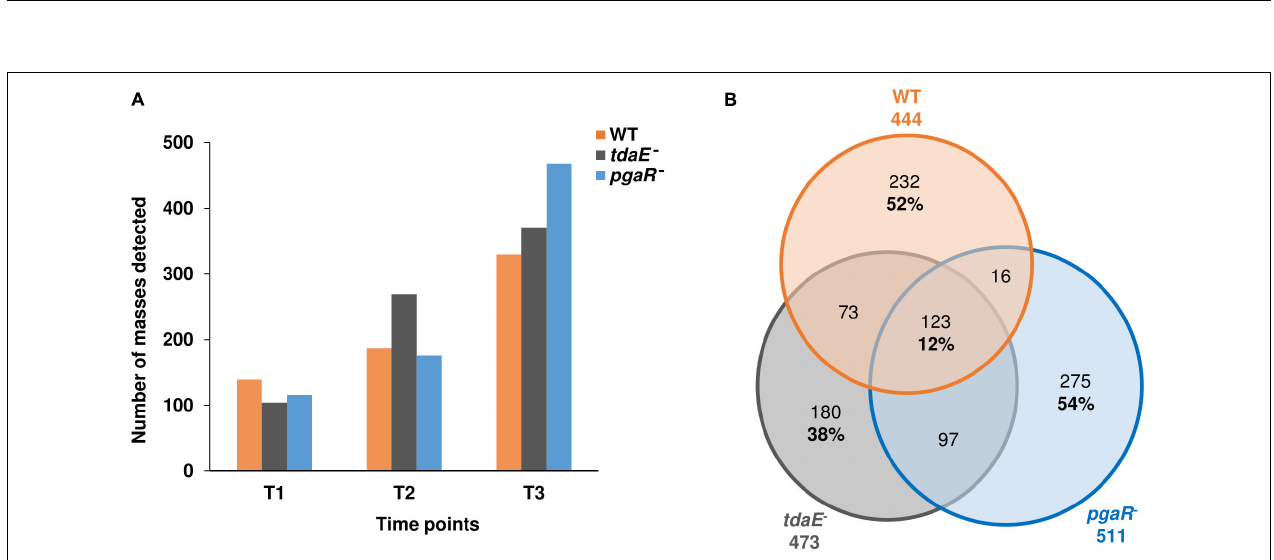
FIGURE 3 | Overall richness of exometabolomes. (A) Number of masses detected in the exometabolome of P. inhibens DSM 17395 wild type (WT), tdaE − mutant and pgaR − mutant at lag (T 1 ), mid-exponential (T 2 ) and early stationary (T 3 ) growth phases. (B) Venn diagram showing the number of unique and shared masses detected in the exometabolome of P. inhibens DSM 17395 WT (orange), tdaE − mutant (gray) and pgaR − mutant (blue) over all time points. Only masses detected in all biological replicates of each strain were considered.